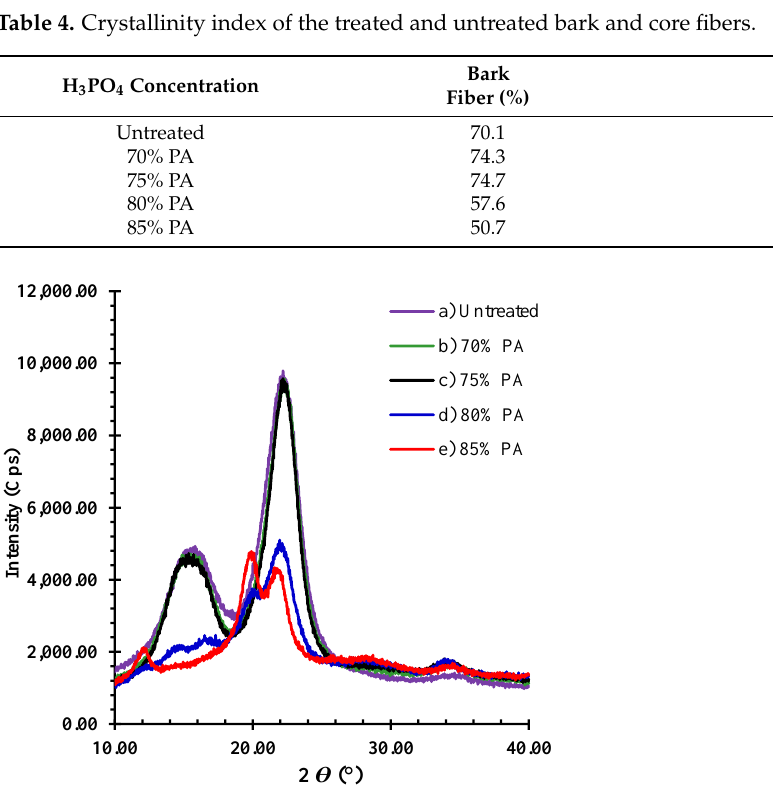
Figure 6. X-ray diffractogram pattern of treated and untreated bark fibers.